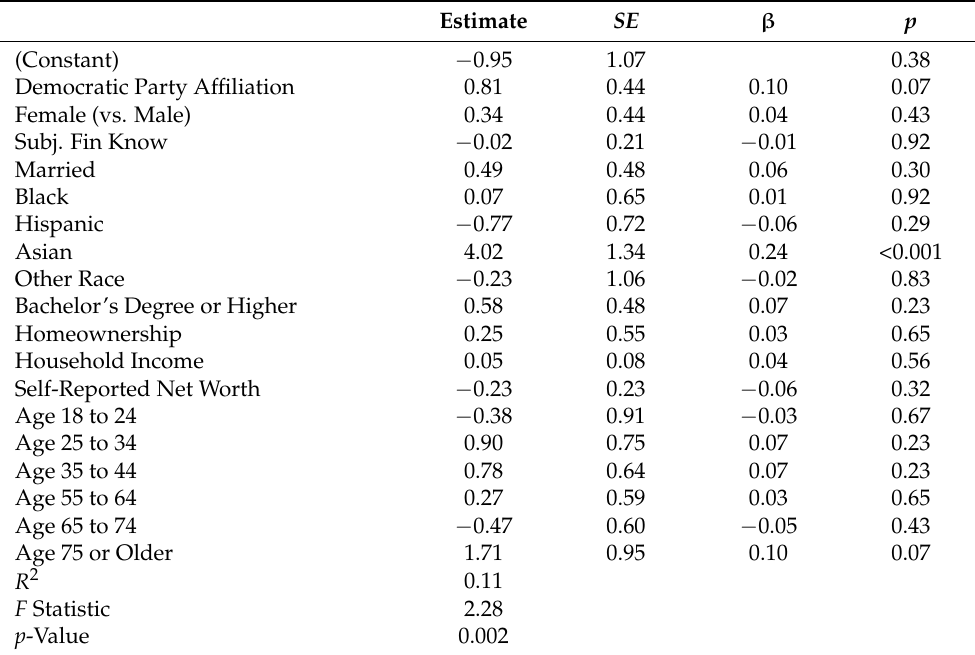
Table 8. Regression showing change in financial risk tolerance (FRT) from the Wave 1 to Wave 2 survey based on Democratic Party